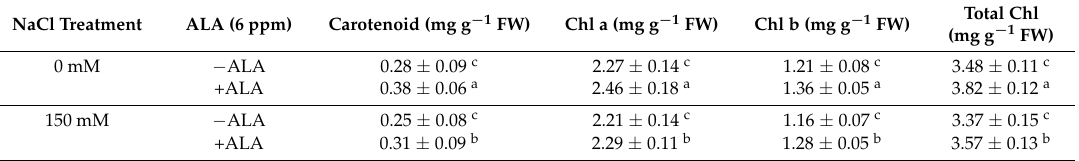
Table 4. Contents of chlorophyll a (Chl a), chlorophyll b (Chl b), total chlorophyll, and carotenoid in the leaves of the Nain Ordinaire cultivar, following salinity (150 mM NaCl) and 5-aminolevulinic acid ([ALA], 6 ppm) treatments.